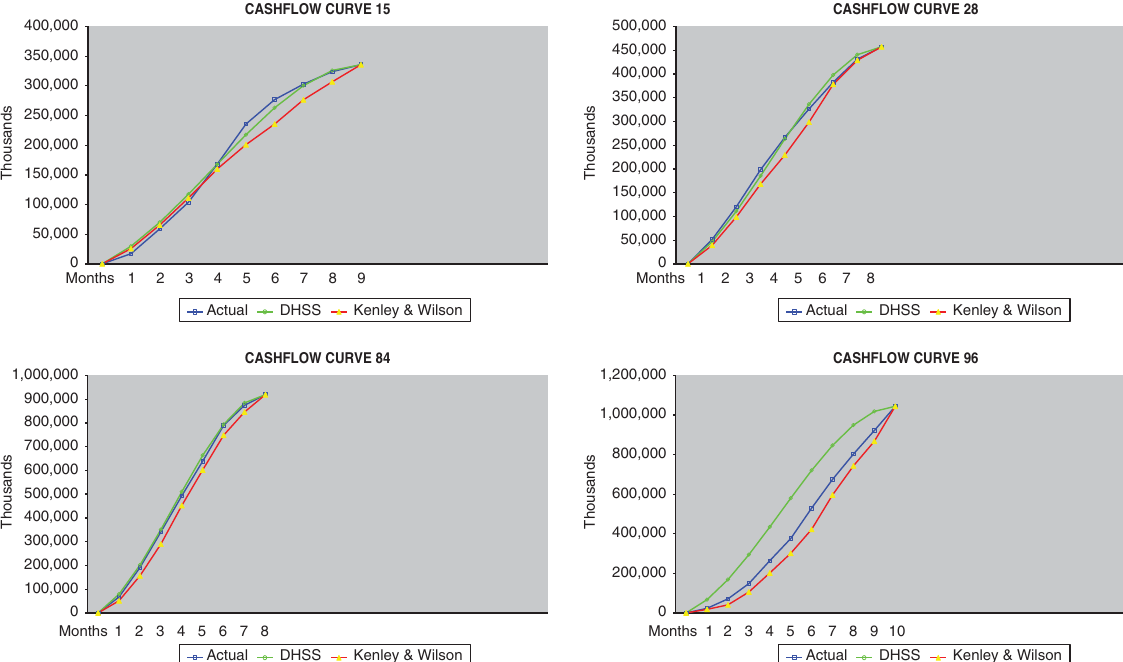
Fig. 6. Cash fl ow curves for projects 15, 28, 84 and